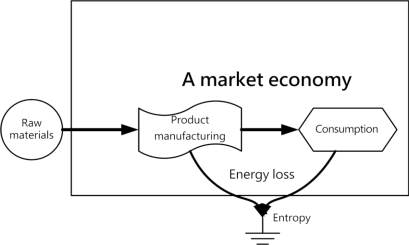
A market economy.